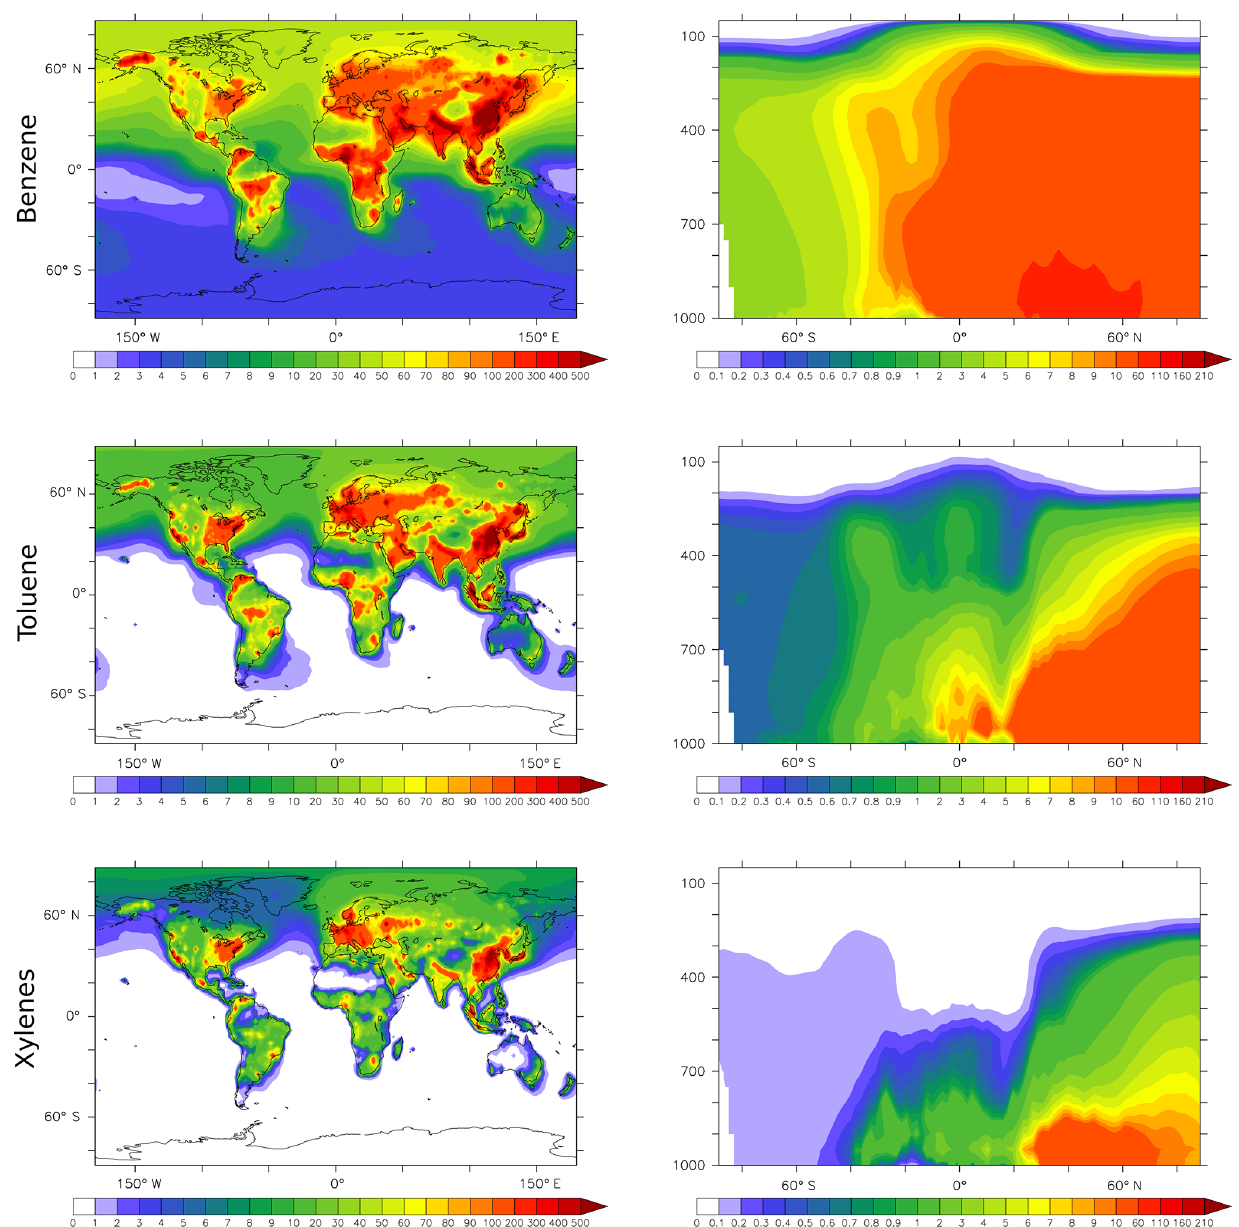
Figure 7. The left column shows annually averaged surface mixing ratios (pmolmol − 1 ) for the RCP simulation. The right column shows the annual zonal average. Upper plots show benzene, the middle toluene and the bottom plots show xylenes. Figures for other species can be found in the